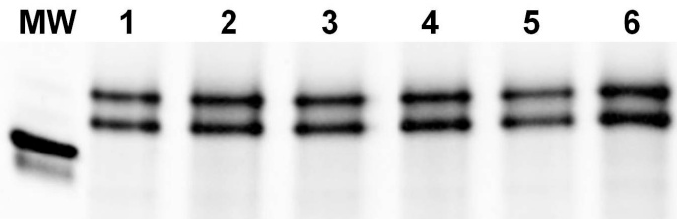
Figure 3. Pina-D1 digestion with Msp I endonuclease. Lanes represent as follows: ( 1) cv. Chinese Spring (Pina-D1a/Pinb-D1a ); ( 2 ) CWI 67429; ( 3 ) CWI 57816; ( 4 ) CWI 67483; ( 5 ) CWI 73046; and ( 6 ) CWI 72689.